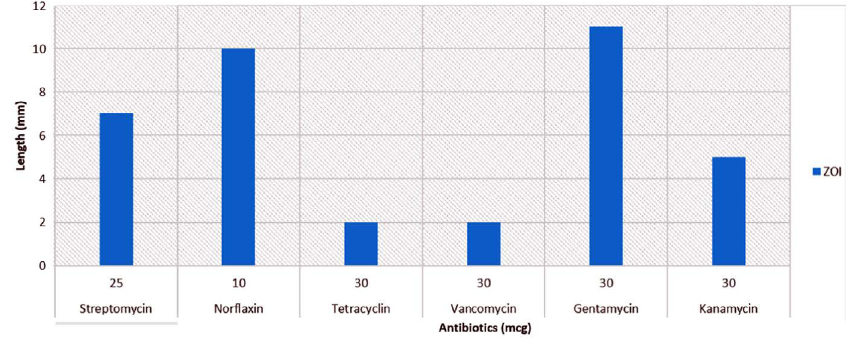
Fig. 2 . Antibiotic resistance of P02 clone. *Resistant (0-4mm), Intermediate (5-8mm) and Susceptible (9-12mm); ZOI= zone of inhibition day (37.05%), 4 th day (39.46%) and 6 th day (41.23%) at 90ppm (Fig. 3). The volatilization efficiency of P02 is more as compared to the volatilization by isolates as reported 9,10